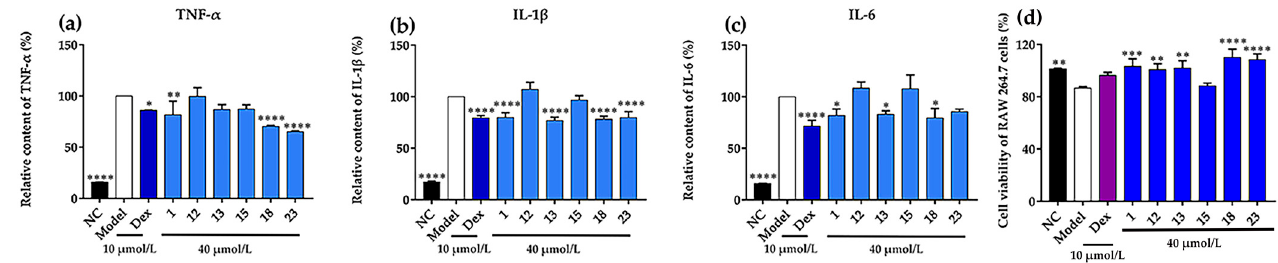
Figure 6. Effect of compounds on cytokine production in RAW 264.7 cells. ( a ) Effect of compounds on TNF- α expression in RAW 264.7 cells. ( b ) Effect of compounds on IL-1 β expression in RAW 264.7 cells. ( c ) Effect of compounds on IL-6 expression in RAW 264.7 cells. ( d ) Cell viability of different groups. The cell viability was compared with the model group for significance testing. All values are mean ± SD from three independent experiments. Significance is denoted by symbols: * p < 0.05, ** p < 0.01, and *** p < 0.001, **** p < 0.0001. NC: blank control group, Model: model control group, Dex: positive control group.